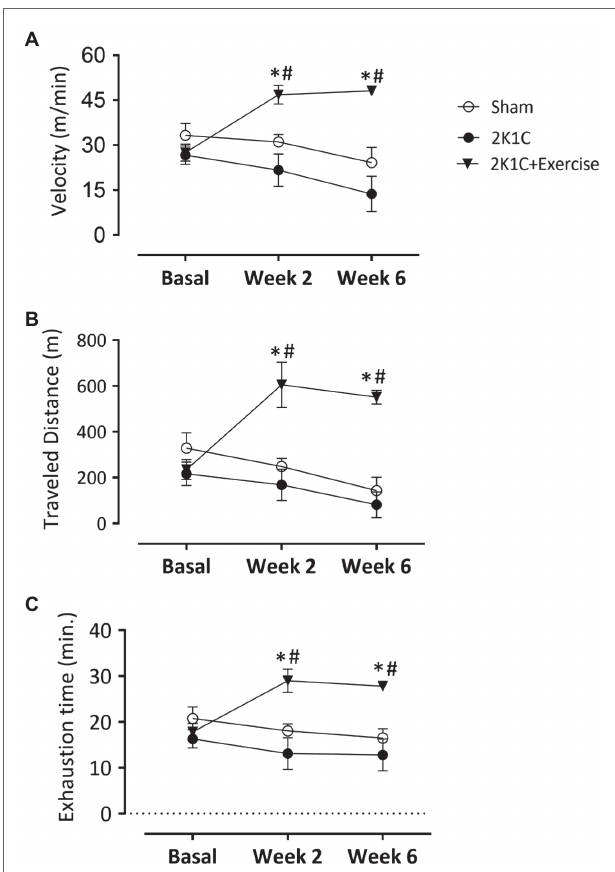
FIGURE 3 | Monitoring parameters of treadmill training in normotensive and hypertensive 2K1C rats. Boxes: (A) velocity values (m/min); (B) distance covered (m); and (C) time of exhaustion (min) in normotensive or 2K1C hypertensive rats. Experimental groups: ○ Sham; ● 2K1C; and ▼ 2K1C + Exercise. Data are presented as mean ± SEM was used, two-way ANOVA, followed by Tukey’s test. Significance: p < 0.05: * vs. Sham; # vs. 2K1C.